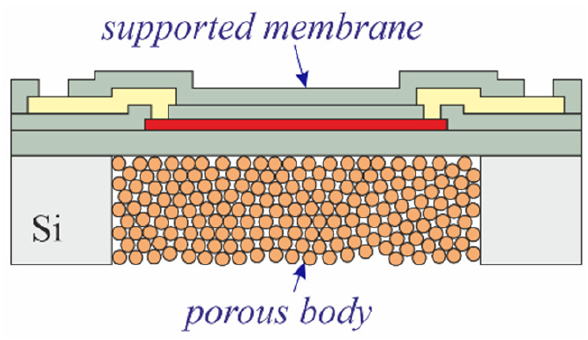
Figure 5. Cross-sections through finished sensor with porous PowderMEMS isolation according to Figure 2c.